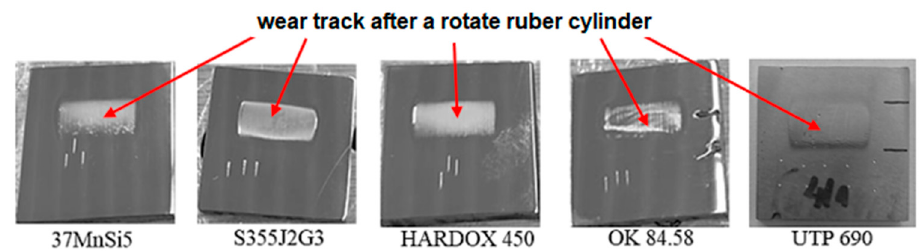
Figure 10. Samples after abrasive wear test.